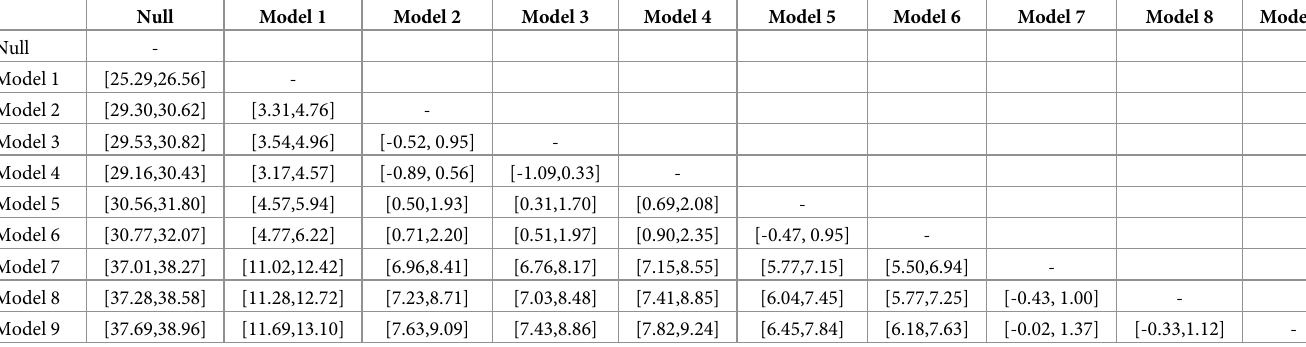
Table 6. 95%CIs of bootstrapped AIC differences between